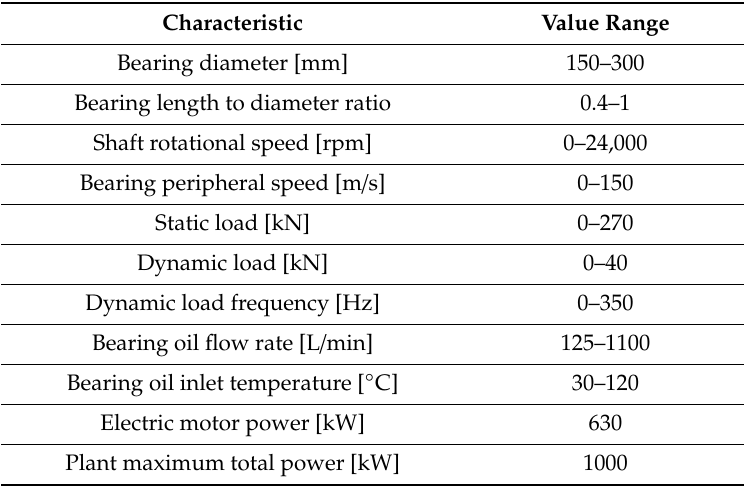
Figure 3. Test cell displacement and acceleration sensor positions.